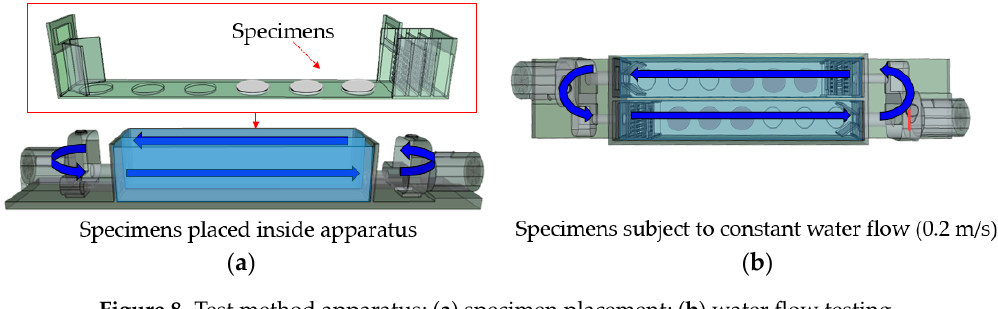
Figure 8. Test method apparatus; ( a ) specimen placement; ( b ) water flow testing.